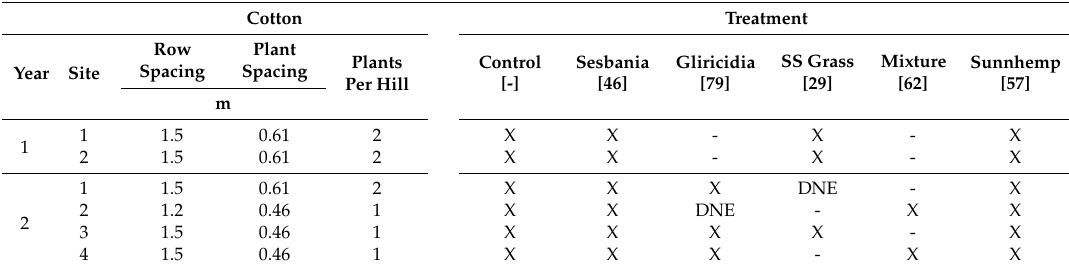
Table 1. Living mulch treatments used at each trial site during the two trial years. Cotton seeding rates and planting patterns are also listed a,b,c .